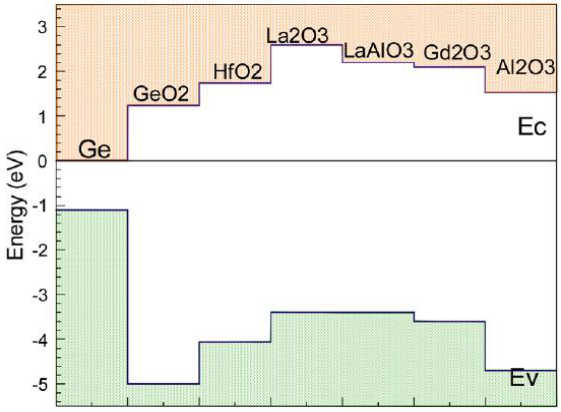
Figure 6. Calculated band offsets of oxides on Ge, reprinted with permission from